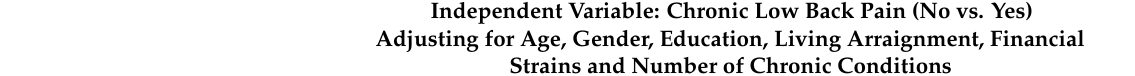
Dependent/Outcome